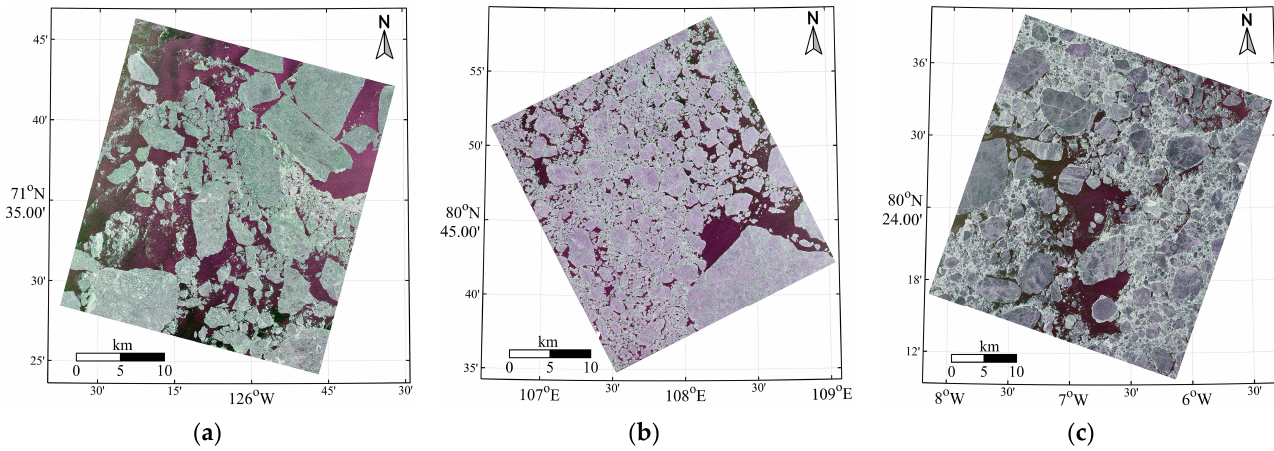
Figure 2. RGB composite images ( σ (cid:2932)(cid:2932)(cid:2868) , σ (cid:2932)(cid:2918)(cid:2868) , and σ (cid:2918)(cid:2918)(cid:2868) ) of ( a ) scene R1-1, ( b ) scene R2-6 and ( c ) scene R3-15. Details of the GF-3 QPS scenes are provided in Table 1.